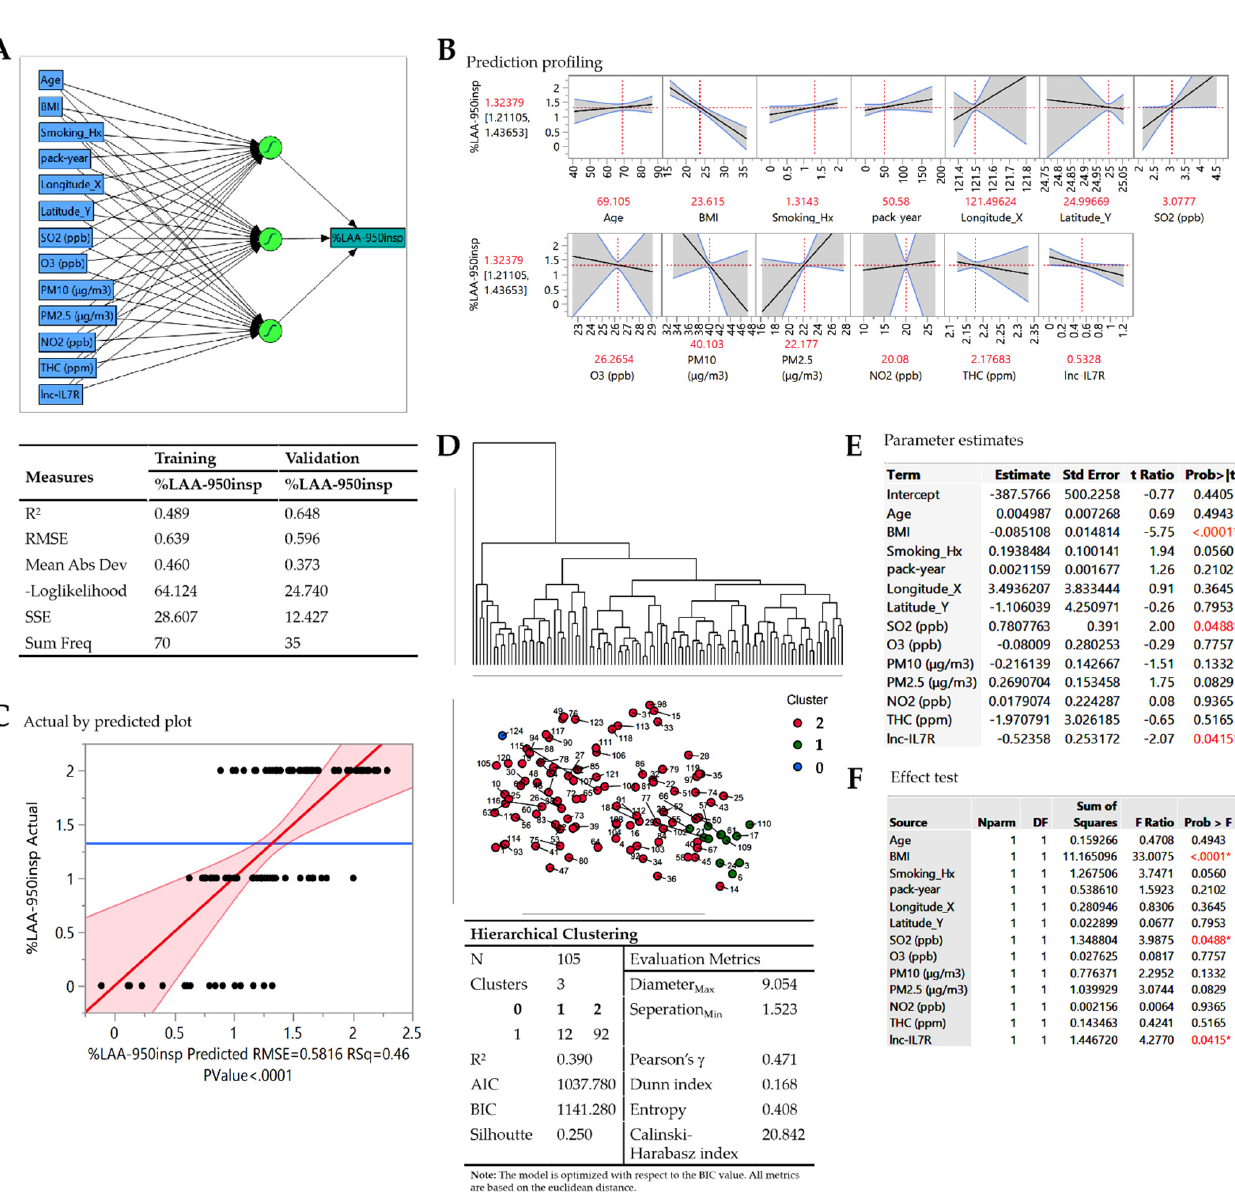
Figure 2. Delineating predictors of disease severity in Taiwanese patients with COPD-E. ( A ) Artificial neural network (ANN) model schema (upper panel) and statistics chart (lower panel) showing the 13 disease-related variables of interest input, 3 auto-determined hidden, and predicted %LAA -950insp -based COPD-E severity output layers. ( B ) Prediction profiler showing the effect of age, BMI, smoking history, pack-year, longitude, latitude, SO 2 , O 3 , PM 2 . 5 , PM 10 , NO 2 , THC, and lnc-IL7R on predicted %LAA -950insp -based COPD-E severity. Cut-off values are indicated in red. ( C ) Actual vs . predicted %LAA -950insp -based COPD-E severity plot. ( D ) Hierarchical clustering dendrogram and statistics of severity-stratified COPD-E cases. ( E ) Parameter estimates, and ( F ) effect test charts of the panel of variables. R 2 , coefficient of determination; RMSE, root mean square error; SSE, sum of squared estimate of errors; Hx, history; ppb, part per billion; ppm, part per million; N, number of cases; AIC, Akaike’s Information Criteria; BIC, Bayesian Information Criteria; Values in red, statistically significant